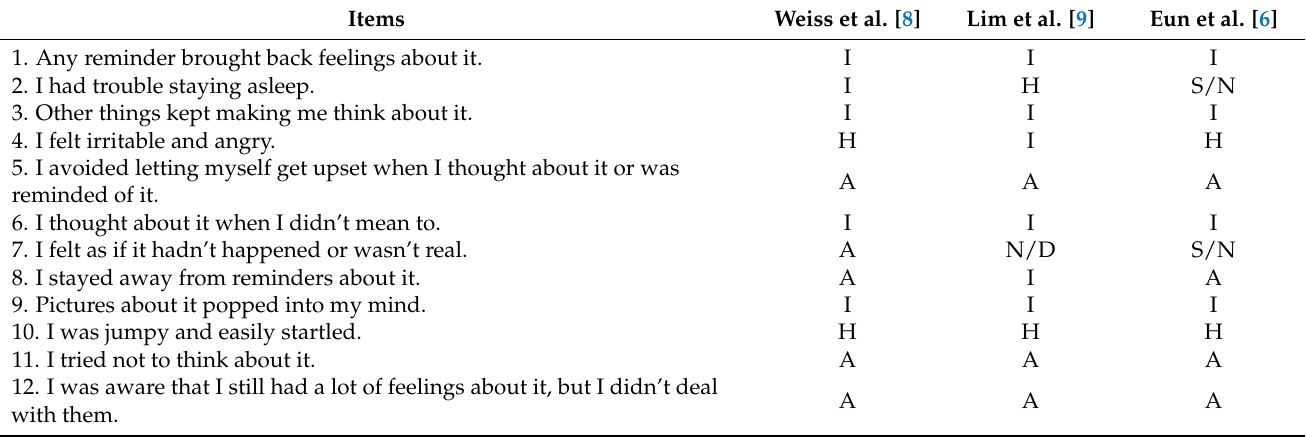
Table 2. Previous studies which conducted exploratory factor analysis for IES-R.